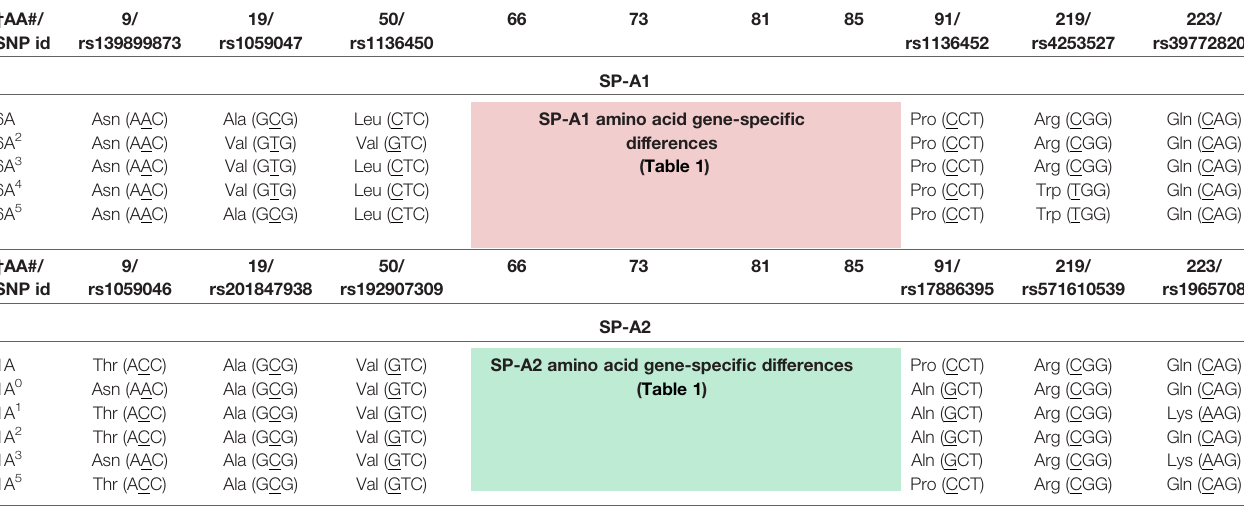
TABLE 2 | Amino acid variation among SP-A1 and SP-A2